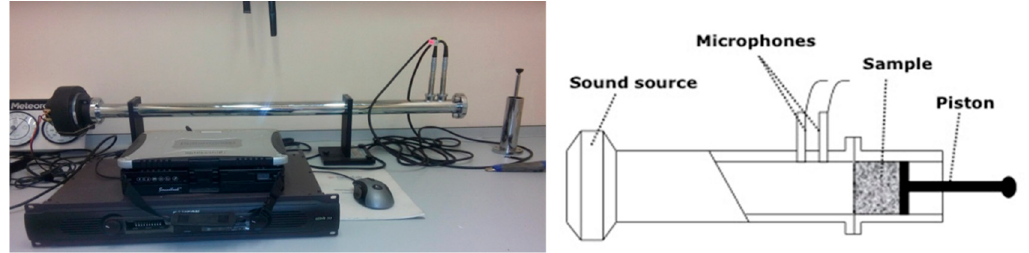
Figure 2. Measurement of sound absorption coefficient by impedance tube.